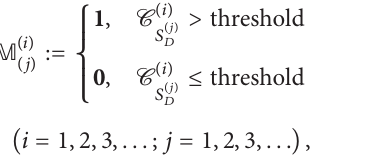
Figure 4: AC waveform